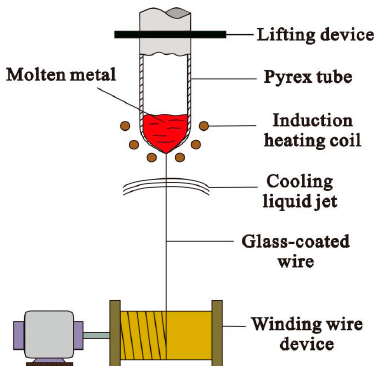
Figure 1. Schematic diagram of the glass ‐ coated melt ‐ spinning process [8,9].